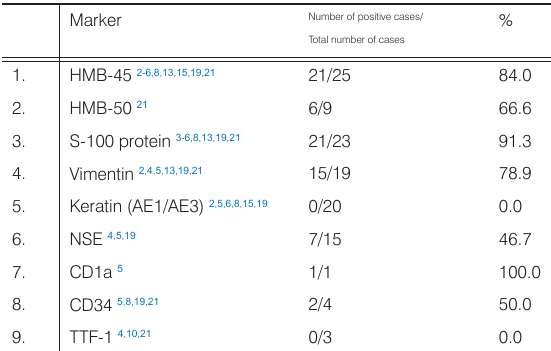
Table 1. Rates of immunohistochemical positivity for clear cell tumor in previous studies [ 2 - 6 , 8 , 10 , 13 , 15 , 19 , 21 ]